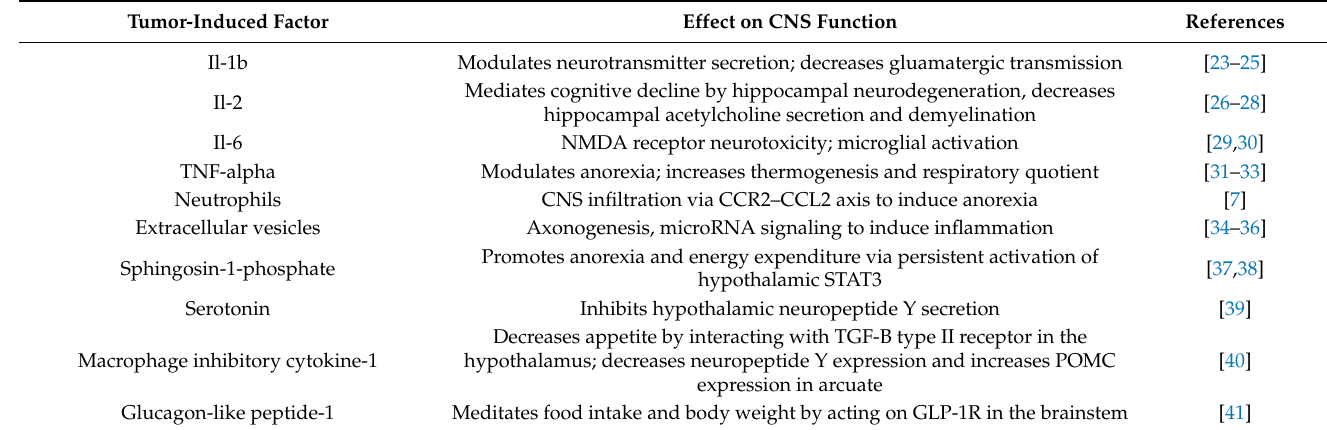
Table 1. Summary of tumor-induced mediators that interface with the brain to mediate cachexia symptoms. Tumor-Induced Factor Effect on CNS